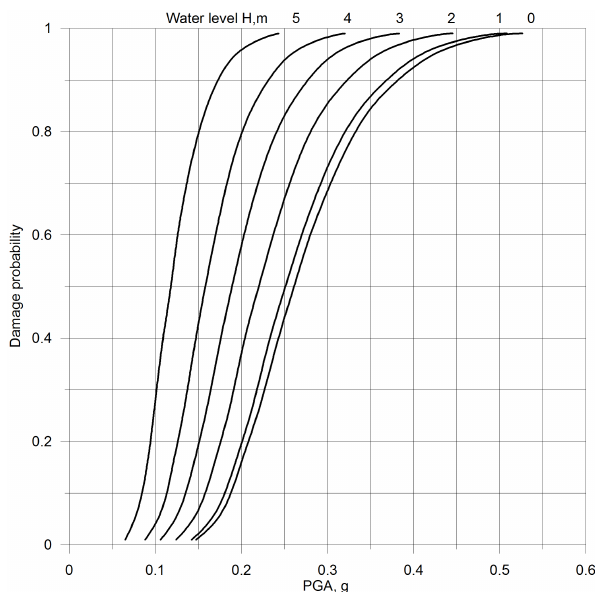
Figure 4. Dike failure probability in the PGA and water level space. Figure 5. Fragility functions for earthen dikes for different water levels ranging from the dike toe to the assumed crest